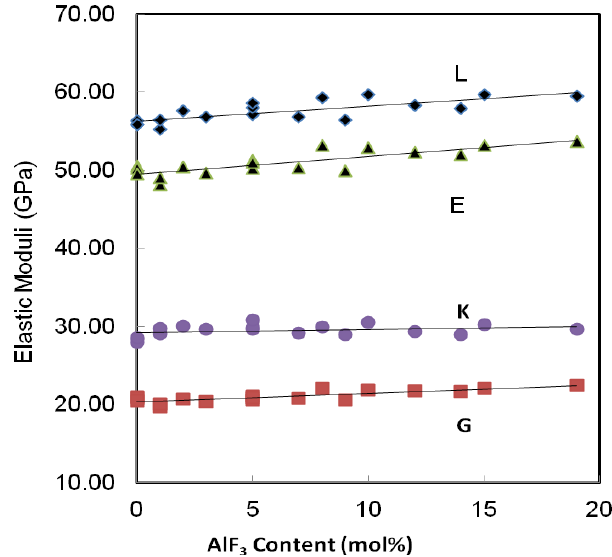
Figure 5. Variation of elastic moduli in the AlF guide the